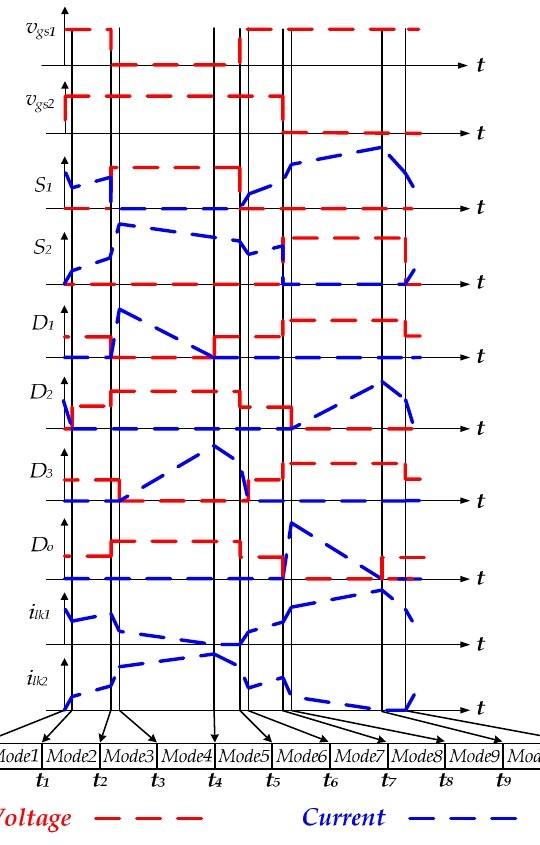
Figure 3. Conceptual key waveforms of the proposed NIC.